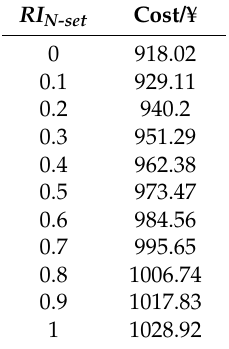
Table 3. Electricity cost under different robust indexes of the elevator system (up-peak